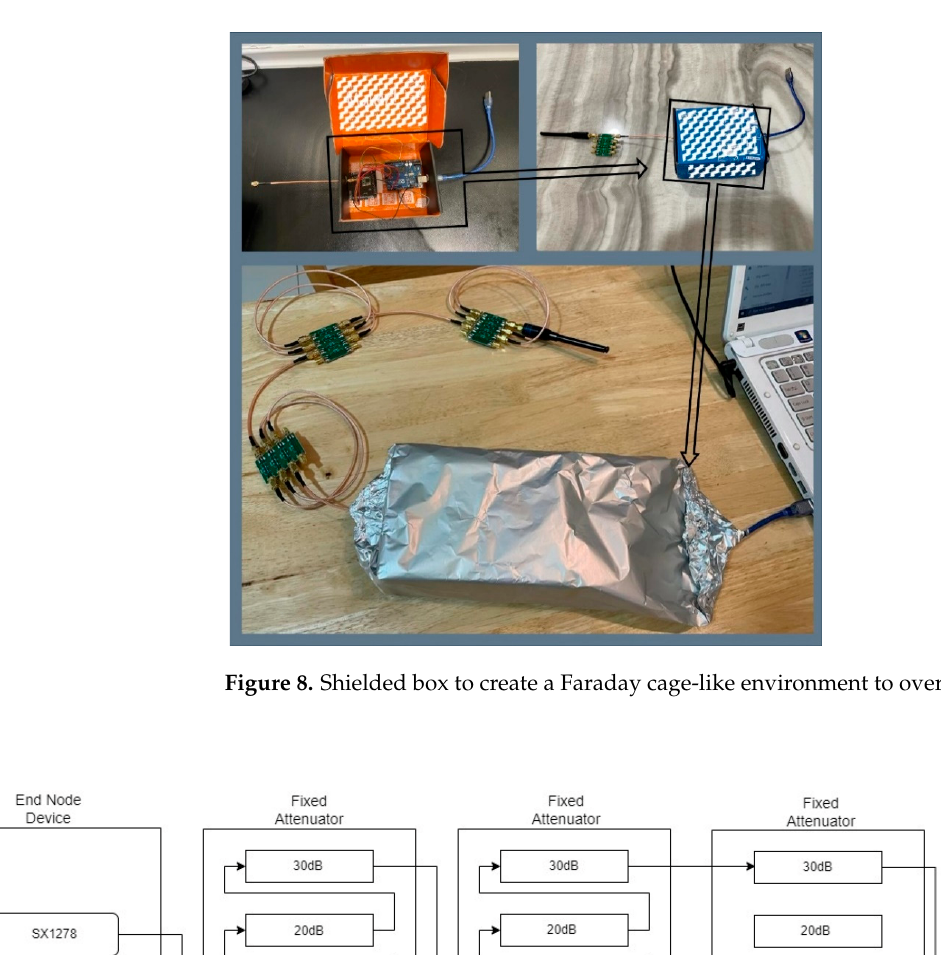
Figure 8. Shielded box to create a Faraday cage-like environment to overcome signal leakage.